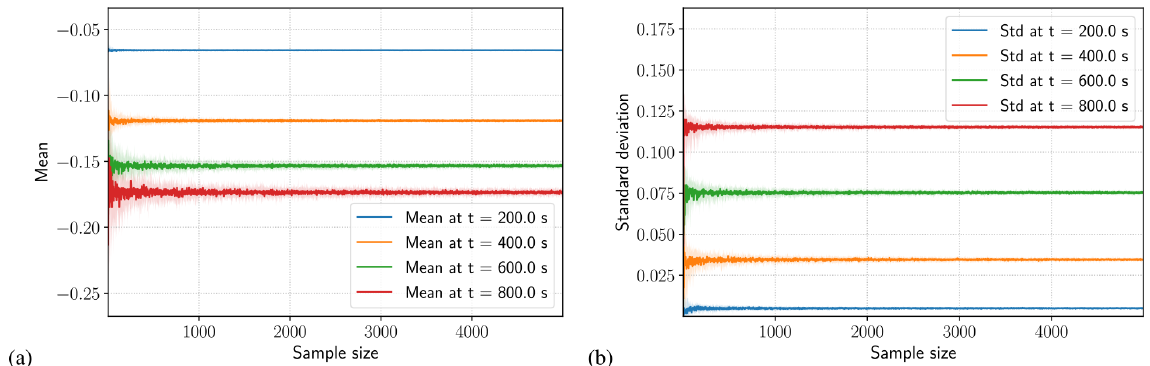
Figure C1. Mean and standard deviation convergence for case 1 for temperature (a) and frazil (b) .